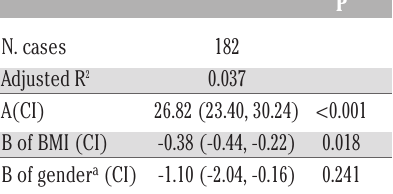
Table 3. Multivariate linear regression for Centre for Epidemiologic Studies- Depression Scale with gender and body mass index as independent